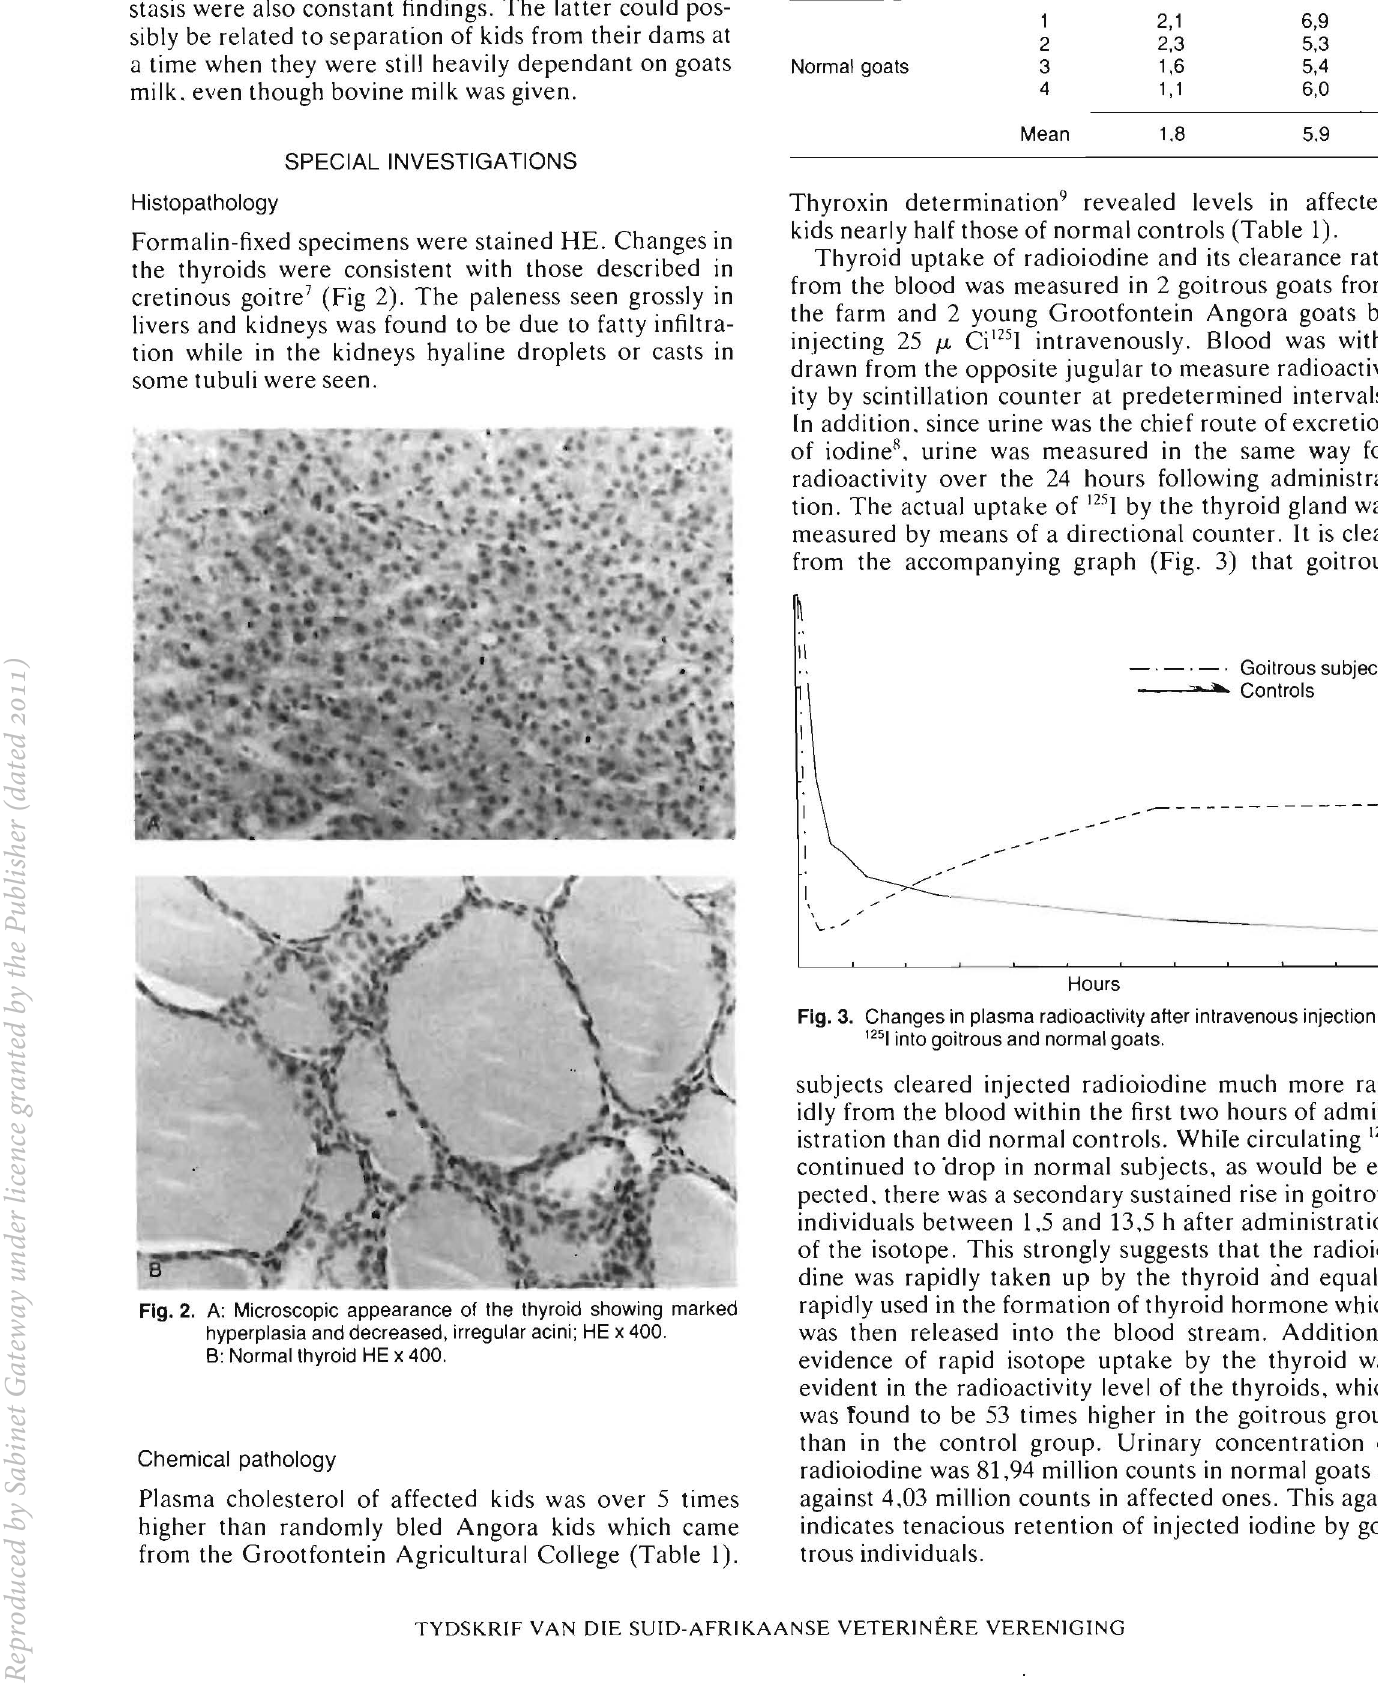
Fig. 2. A: Microscopic appearance of the thyroid showing marked hyperplasia and decreased, irregular acini; HE x 400. B: Normal thyroid HE x 400.